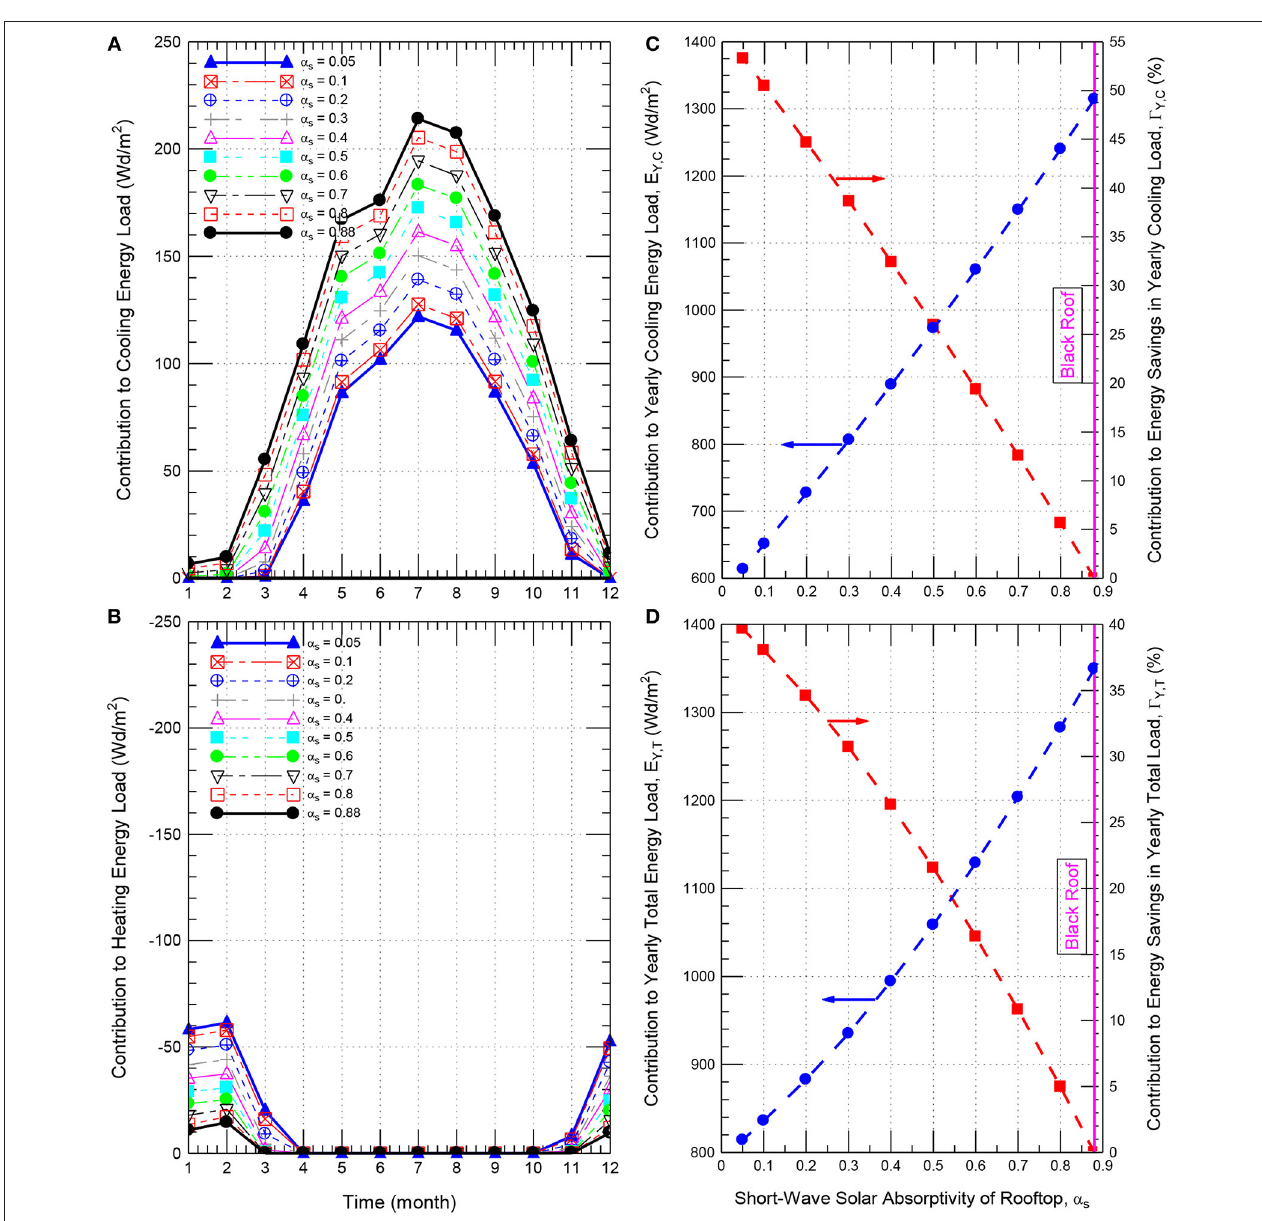
FIGURE 11 | Effect of the rooftop short-wave solar absorption coefficient on the contributions to the monthly cooling and heating energy loads (A,B) and yearly cooling and total energy loads (C,D) for roof having 1 ins = 102mm (4.0